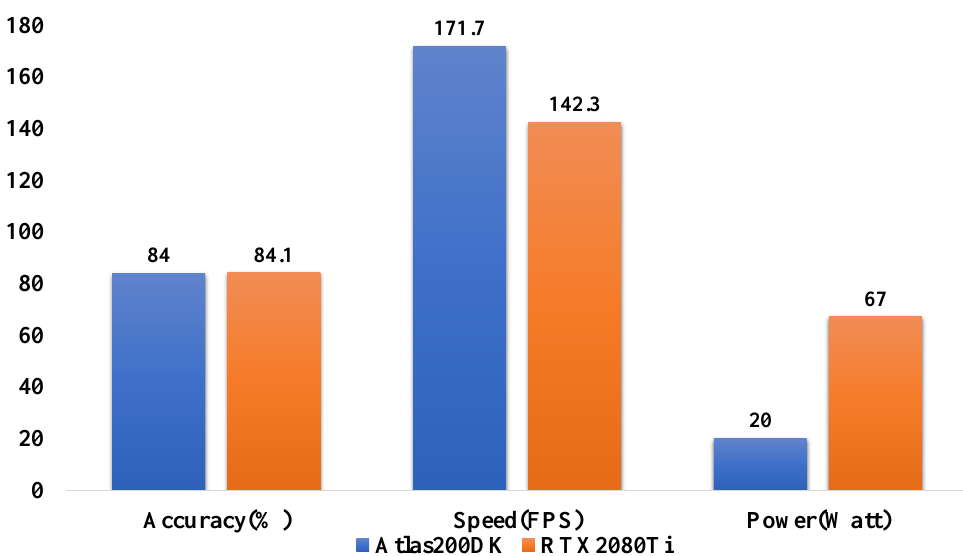
Figure 6. Performance comparison between Atlas200DK and RTX2080Ti (running ADGCN